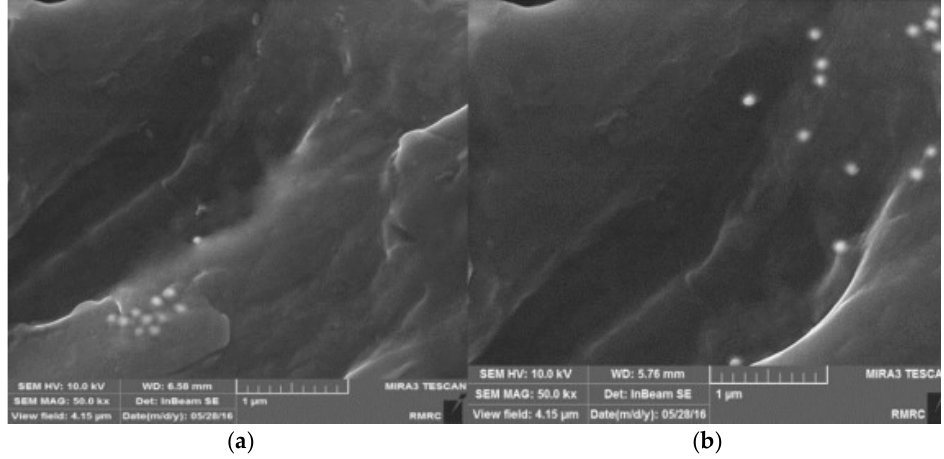
Figure 18. Aggregation of TiO2 nanoparticles in paraffin PCM, ( a ) without SSL, and ( b ) with SSL. (Reprinted with permission from ref. [60]. Copyright 2017 Applied Thermal Engineering).